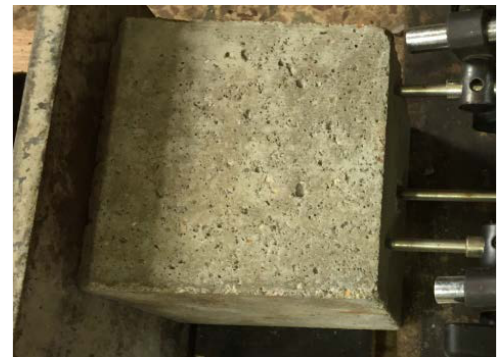
Figure 5. Failure mode of pullout specimen.